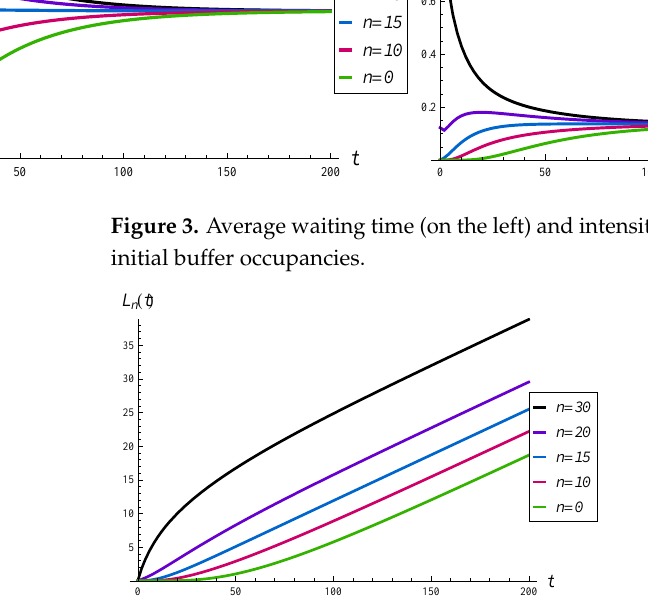
Figure 4. Average number of losses in ( 0, t ) for different initial buffer